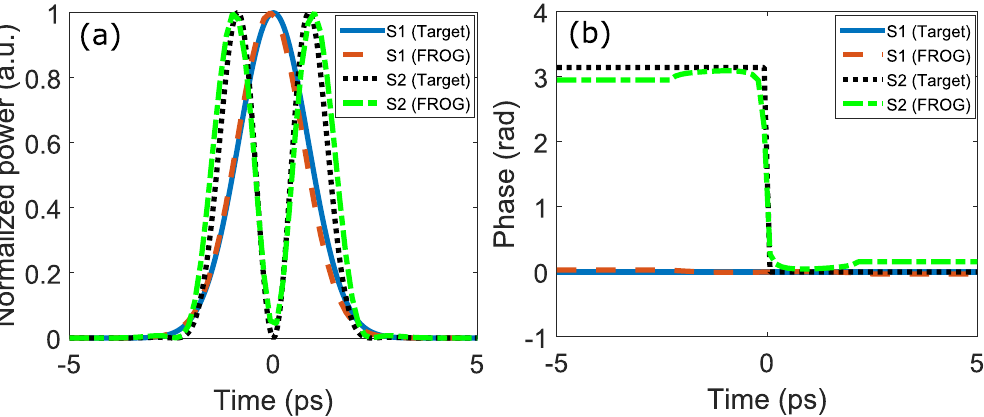
Figure 4. Retrieved pulse shapes. Two examples of the created pico-seconds pulses used in the experiment and retrieved pulse shapes by FROG, showing the normalized power ( a ) and phase profiles ( b ). The non-zero dip in ( a ) is likely due to the measurement noise of the FROG and the slight error in waveform retrieval. Note that retrieved phase profiles by FROG in ( b ) are valid when the normalized power is